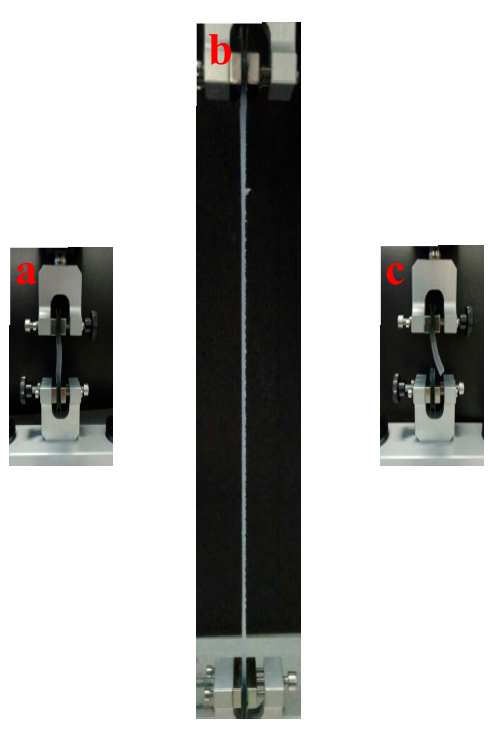
Figure 5. Tensile drawing of the hydrogel sample containing polymerizable microspheres. ( a ) Length: 2 cm, diameter: 1 cm; ( b ) length: 20 cm, diameter: 0.25 mm; ( c ) sample fractured.